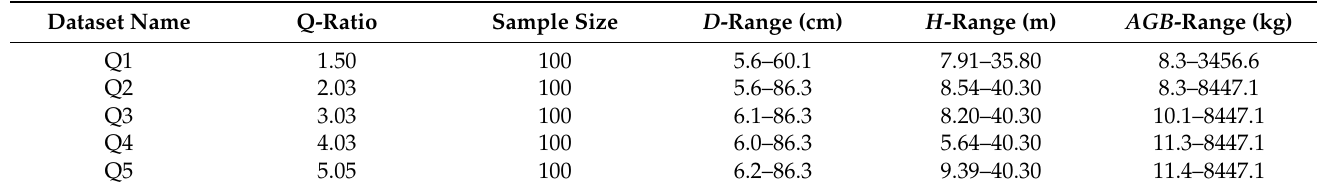
Table 1. The characteristics of the calibration